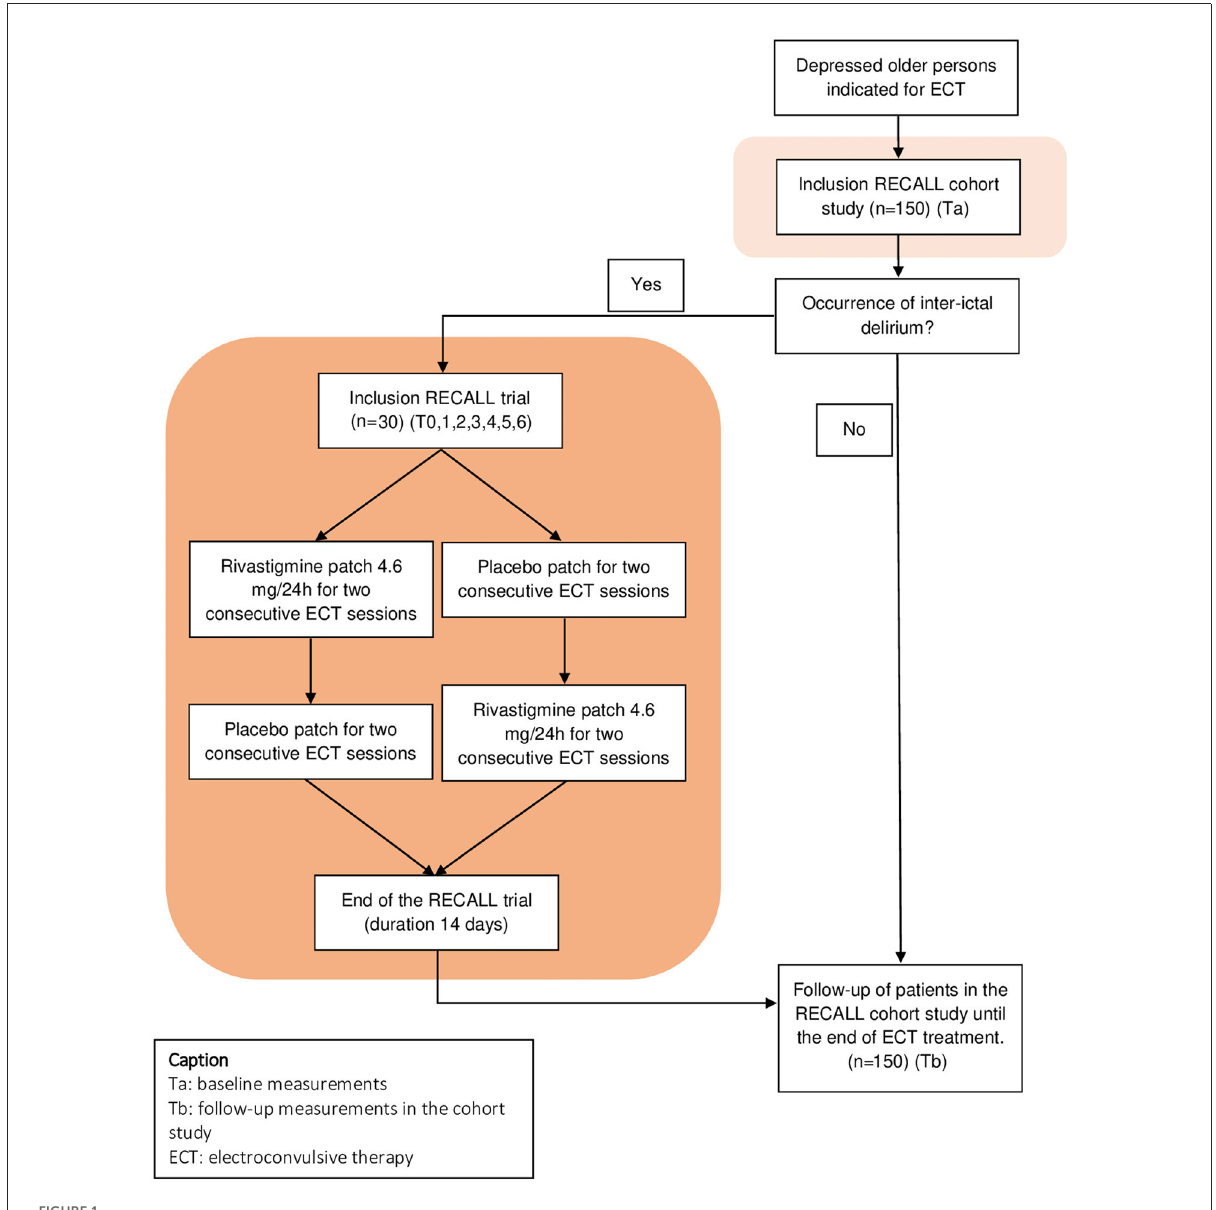
FIGURE1 Schematic representation of RECALL